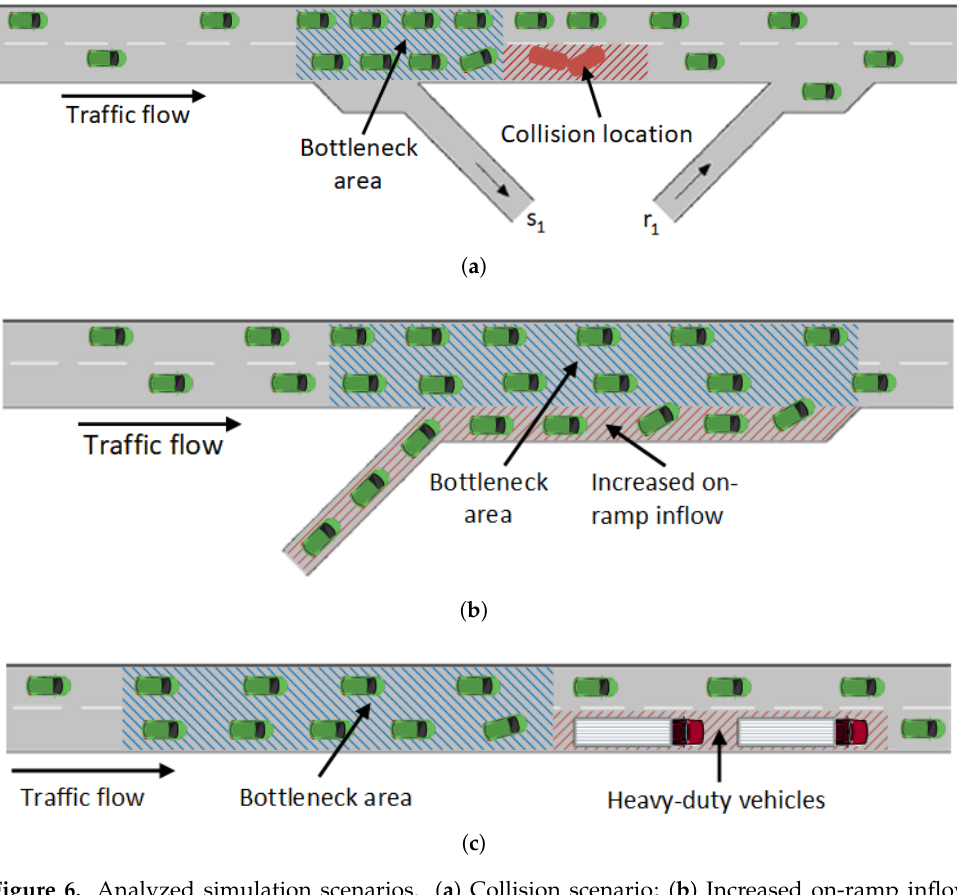
Figure 6. Analyzed simulation scenarios. ( a ) Collision scenario; ( b ) Increased on-ramp inflow scenario; ( c ) Heavy-duty vehicles